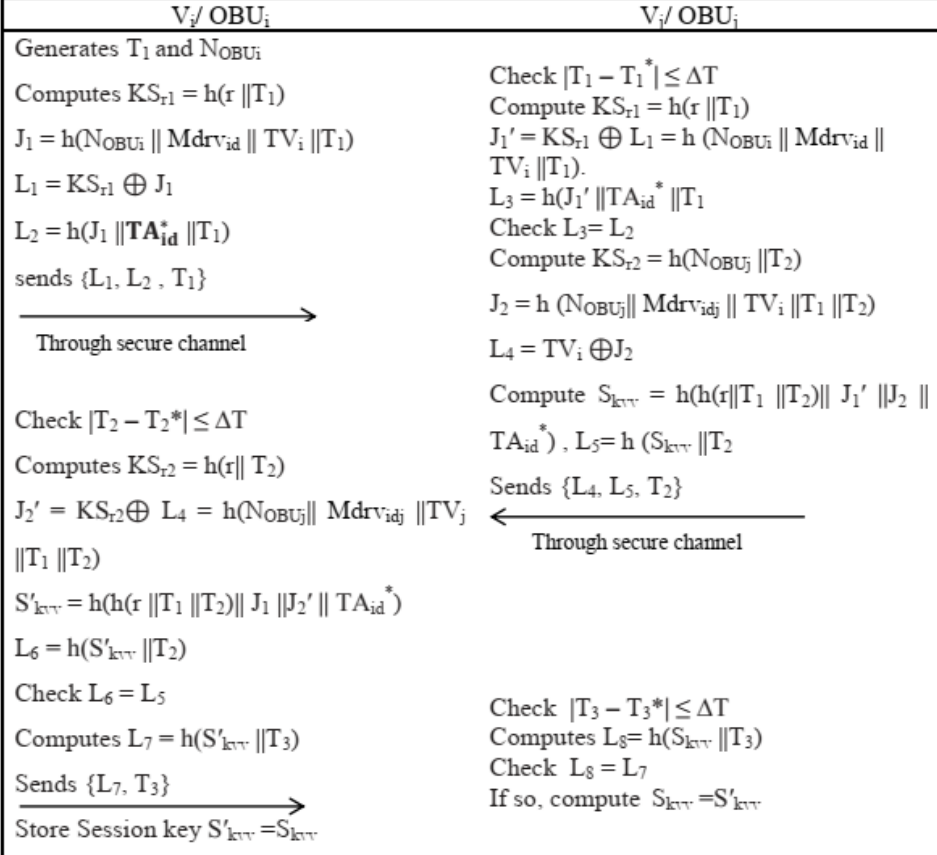
Figure 4. V2V Authentication and Key Establishment Phase.